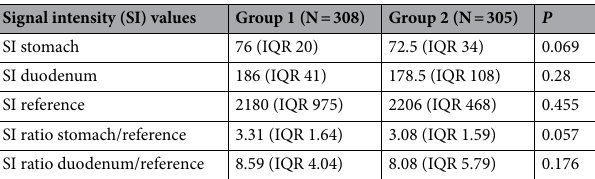
Table 4. Signal intensity values acquired after ingestion of the fruit juice.